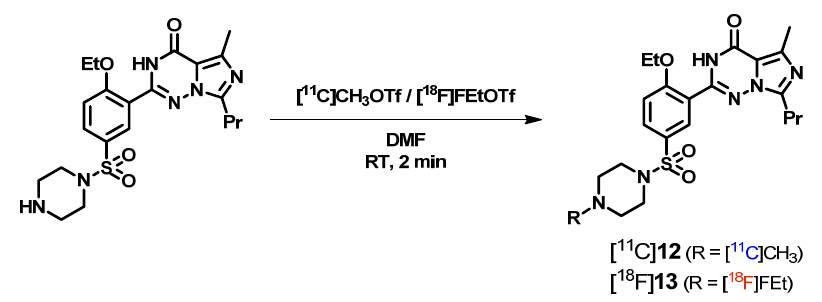
Scheme 5. Radiosyntheses of [ 11 C] 12 and [ 18 F] 13 Scheme 5.